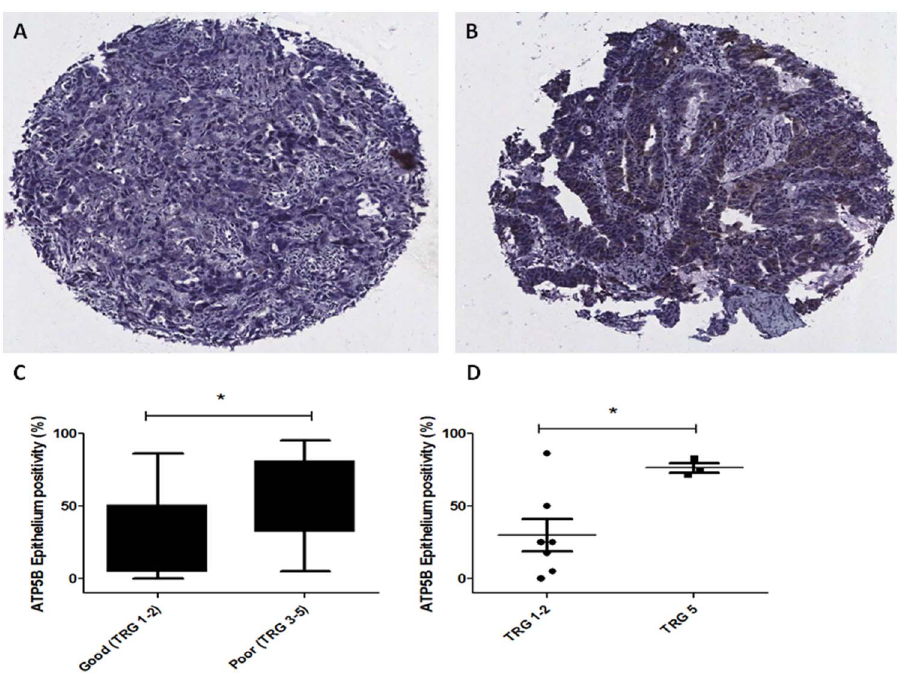
Figure 6. ATP5B expression is increased in the tumour epithelium of poor responders. ATP5B expression was assessed by immunohistochemistry in pre-treatment tumour biopsies from OAC patients who subsequently received neoadjuvant CRT ( n =23). Representative images of ATP5B staining in tumours from good ( A ) and poor ( B ) responders, magnification 10 6 . ( C ) ATP5B positivity in the epithelium is significantly increased in tumours of patients with a poor response to neoadjuvant CRT (TRG 3–5), when compared to good responders (TRG 1 and 2). ( D ) ATP5B positivity in the epithelium is significantly increased in tumours of patients with no evidence of regression (TRG 5), when compared to patients achieving a full (TRG 1) or major response (TRG 2). Statistical analysis was performed by unpaired 2-tailed Student’s t -test, * P ,